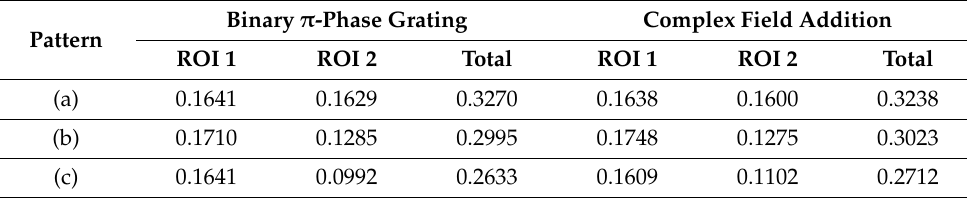
Table 1. Diffraction efficiency for different algorithms of two-point beam steering. Binary π -Phase Grating Complex Field Pattern